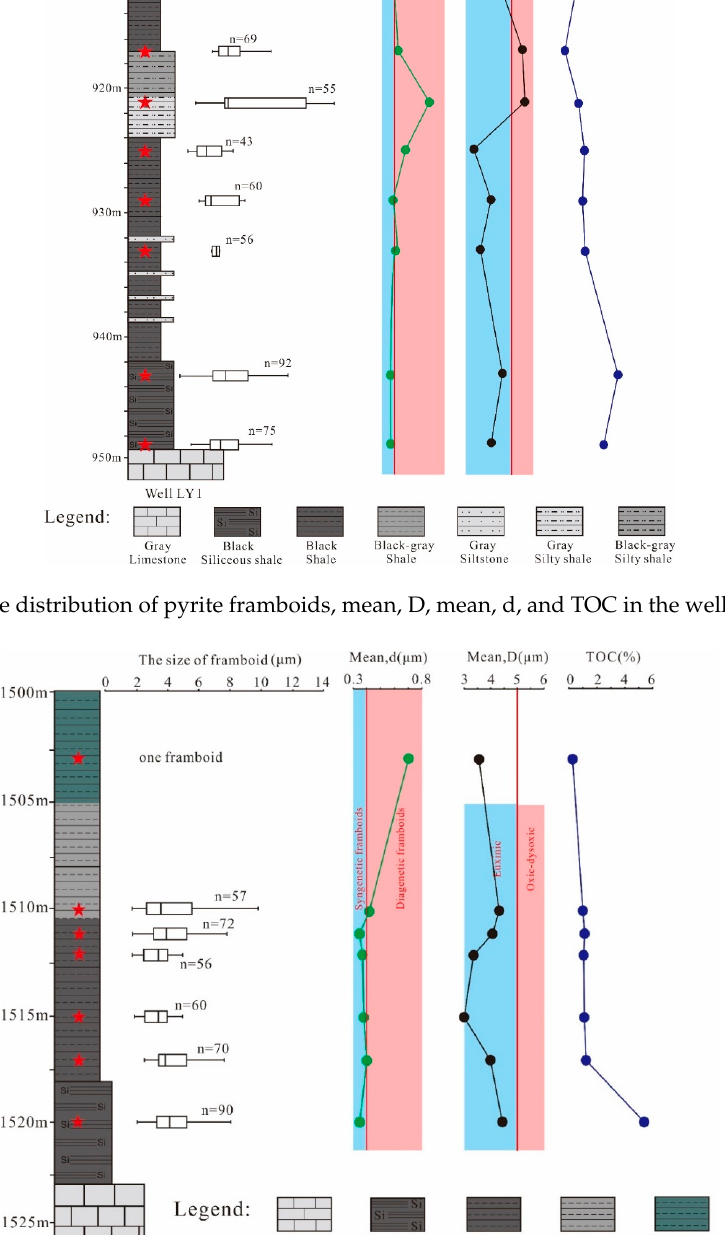
Figure 8. Size distribution of pyrite framboids, mean, D, mean, d, and TOC in the well YY2 shales. Additionally, only one framboid could be observed in the Longmaxi gray-green shales at the depth of 1503 m with a low Mean, D and a relatively high Mean, d in well YY2 (Figure